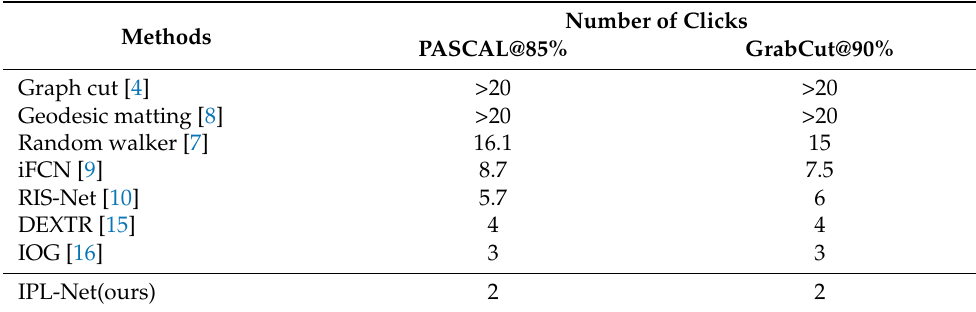
Table 2. The mean number of clicks required to achieve the specific IoU accuracy in PASCAL and GrabCut dataset. Lower is better.